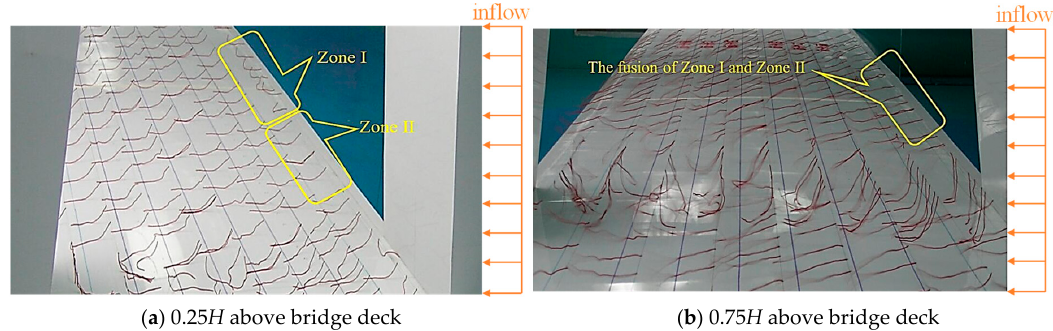
Figure 9. Flow field from experimental results (C2 condition).